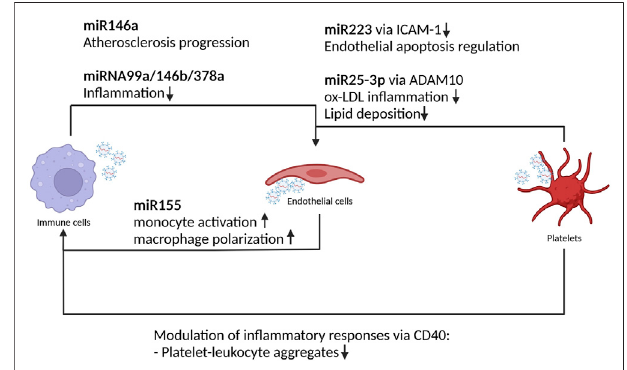
FIGURE 3 | Platelets, immune and endothelial cells derived EVs miRNA effect in atherosclerosis. Schematic representation of the crosstalk between immune cells, EC and platelets driving atherosclerosis pathogenesis. The exchange of miRNA modulates in fl ammatory response and endothelial activation status leading to atherosclerosis onset and